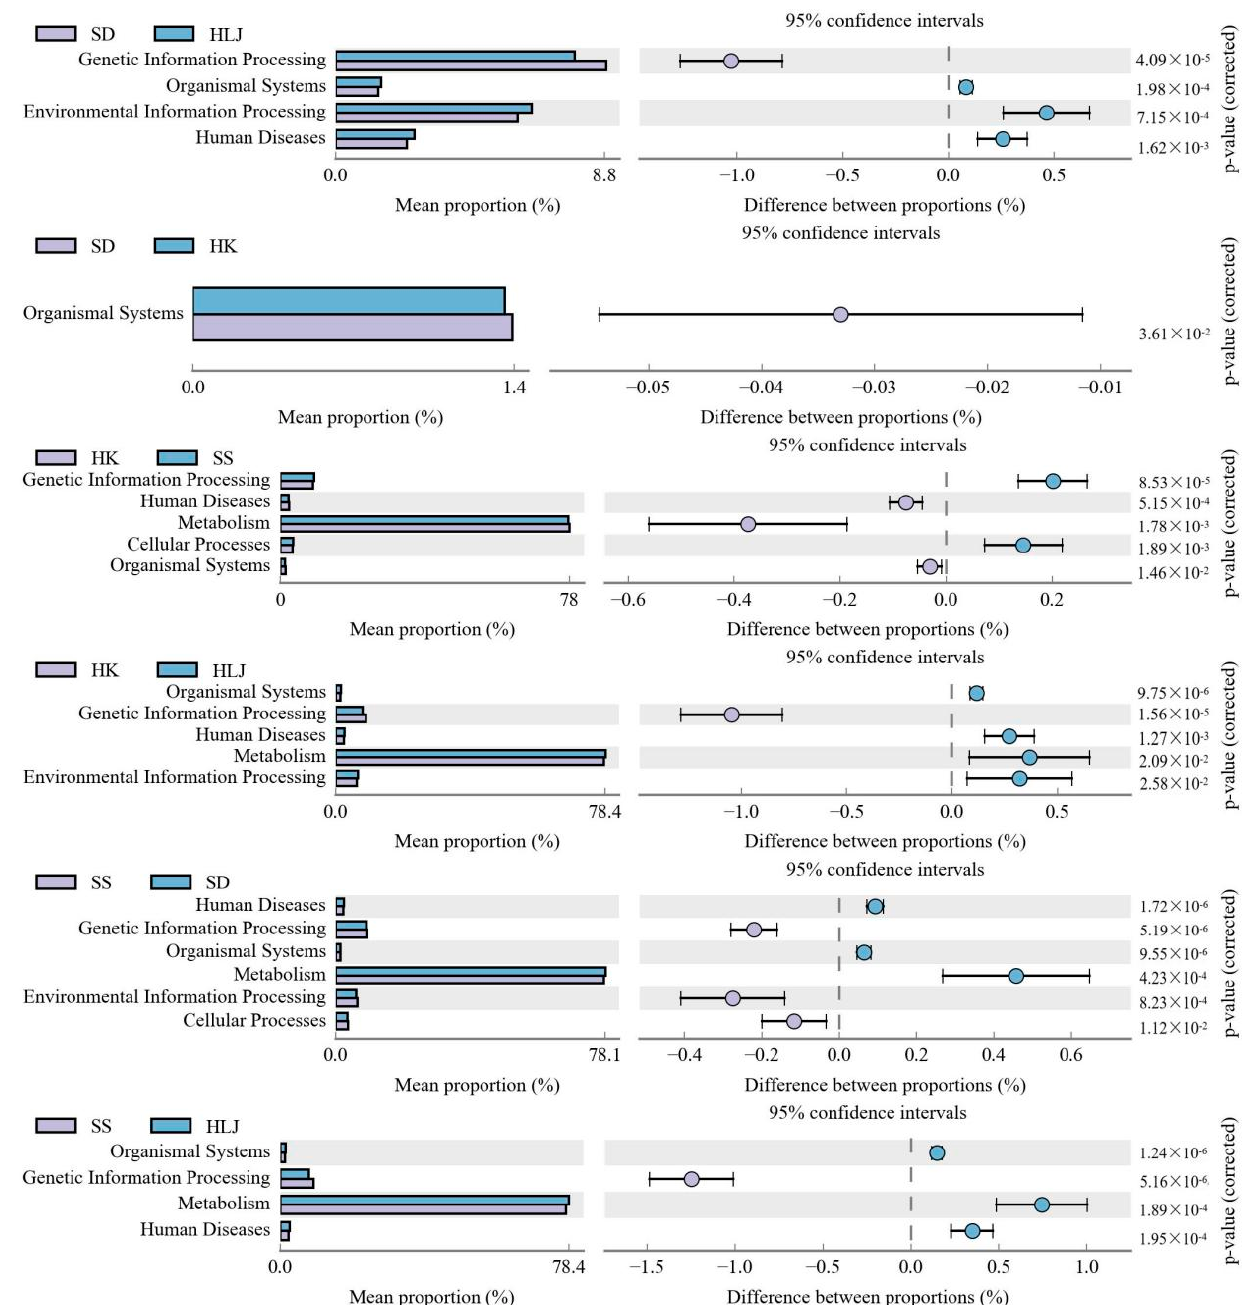
Figure 4. Fecal microbiome functions between comparisons through the enriched KEGG metabolic